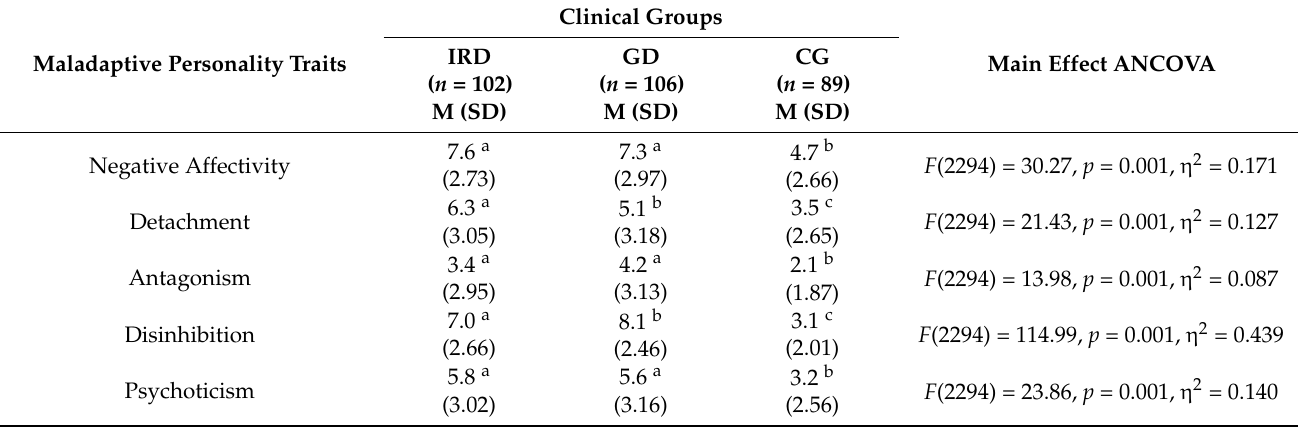
Table 3. Maladaptive personality traits in patients with internet-related disorders, patients with gambling disorder, and healthy